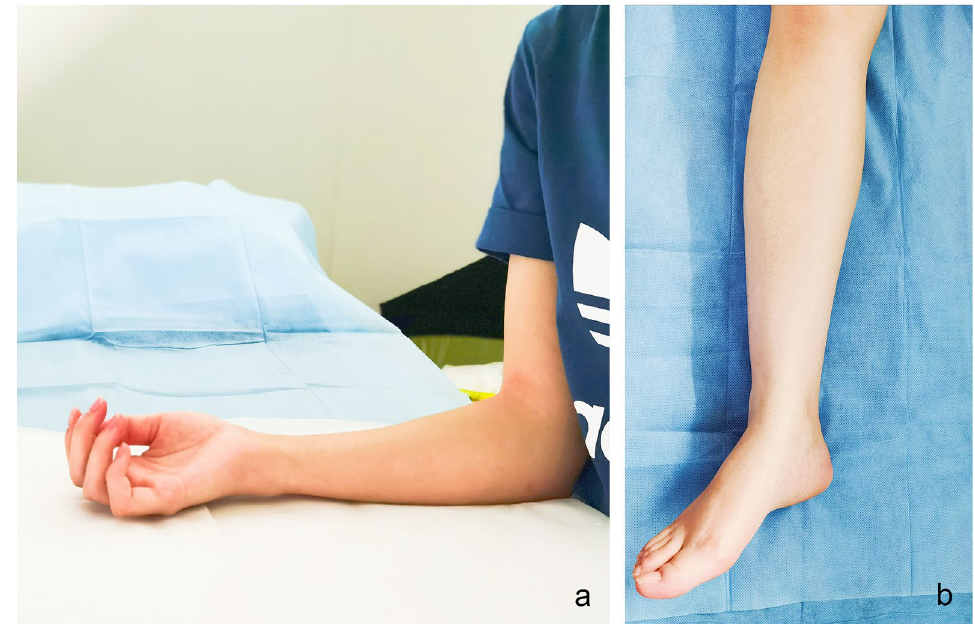
Figure 1. Examples of the position during the assessment. ( a ) the subjects were asked to sit facing the examiner in a neutral position and to keep their forearm in the supine position, upper arms close to the chest wall, the elbow flexed 90°, upper limbs relaxed and fingers naturally semi-flexed during the median nerve scanning; ( b ) the subjects were asked to lie in the supine position. The ankles were positioned in slight plantar flexion and were slightly rotated externally and the lower extremity was in a neutral position during the tibial nerve